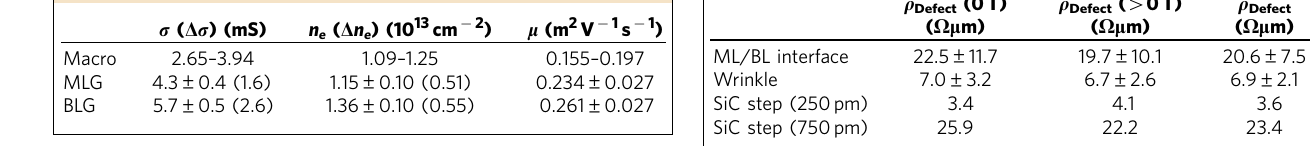
While the first column shows the values for B ¼ 0T, the second one averaged over all data points with applied magnetic field. The last column yields the total average. No errors for the SiC-substrate steps are given due to the small number of data points.